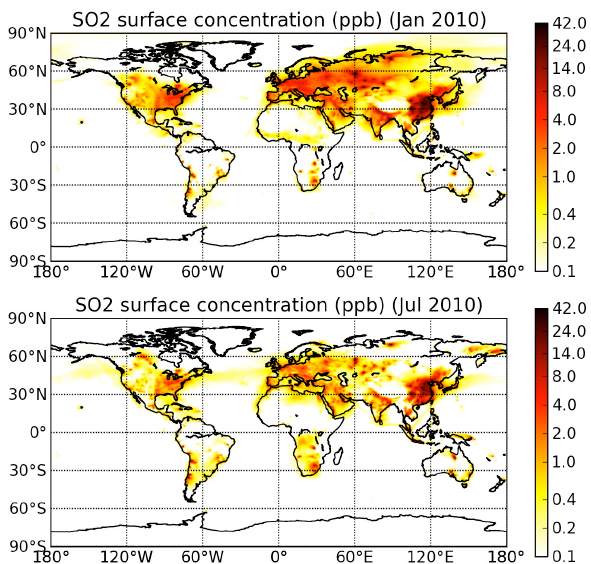
Fig. 2. GEOS-5/GOCART monthly mean of SO 2 surface-level (re- vised run) for January and July